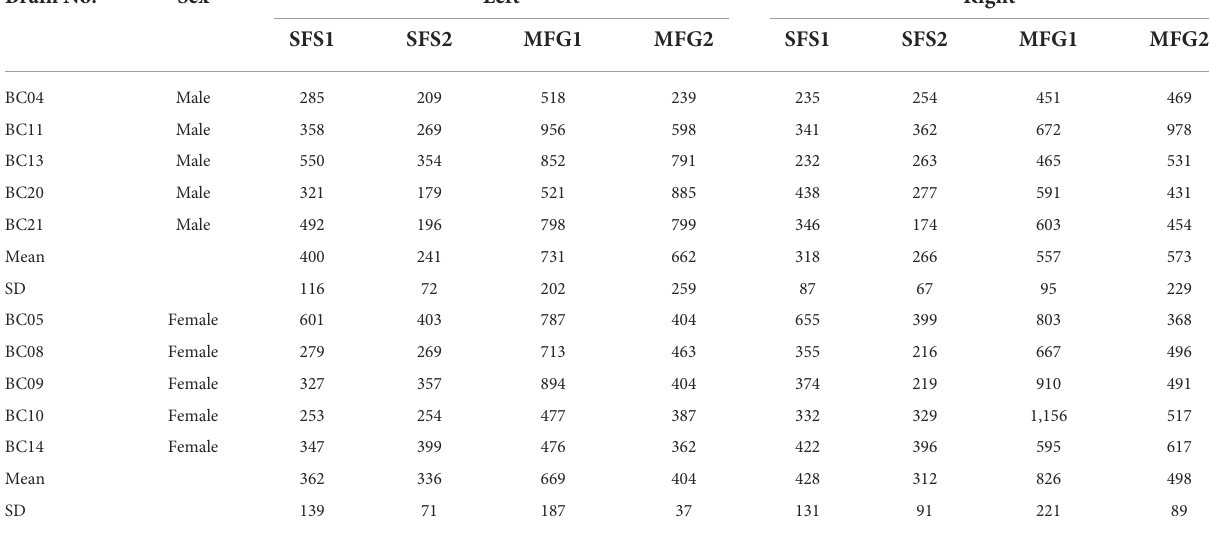
TABLE 4 Shrinkage corrected volumes of areas (mm 3 ). Brain